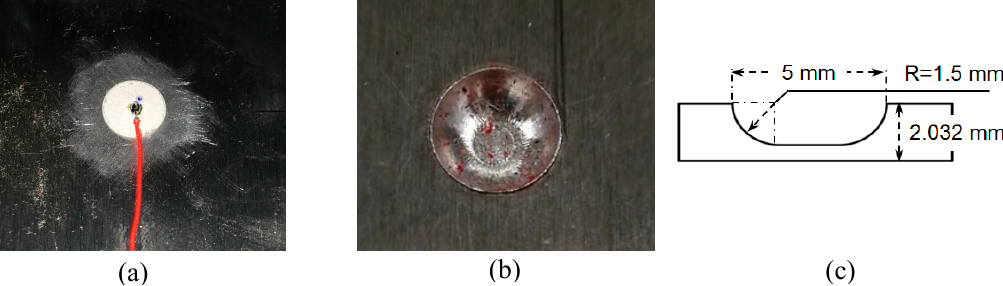
Figure 3. Experimental setup: ( a ) a circular PWAS; ( b ) corrosion damage; ( c ) schematic of the corrosion damage.